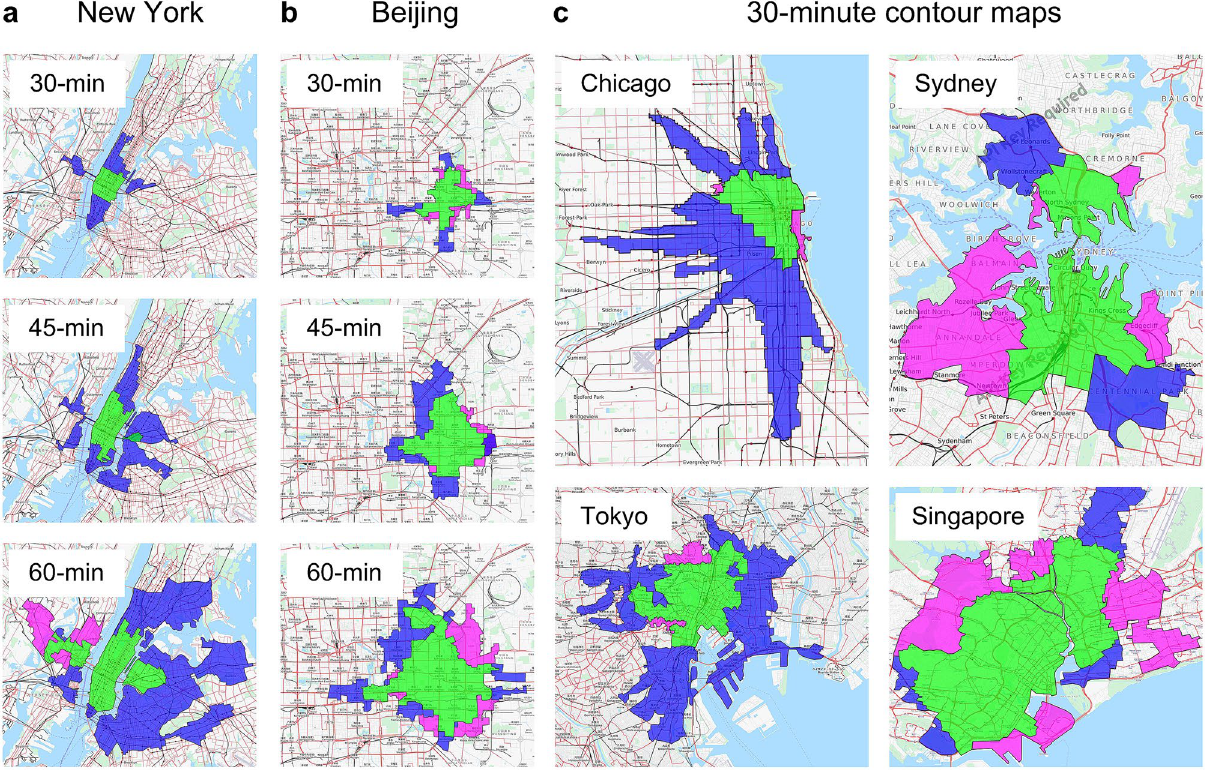
Figure 2. Contour maps of fastest or equal driving time between PT and PCs (Supplementary Tables 2, 3 and 4) . PCs are faster than PT (represented in pink); PT is faster than PCs (represented in blue); and the case of equal travel time (represented in green). ( a ) Contour maps for the Lower Manhattan zone of New York showing the fastest modes for reaching destinations within 30, 45, and 60 min between 5:00 and 6:00 p.m. from midtown. ( b ) Contour maps, similar to ( a ), for Guomao zone of Beijing between 5:00 and 6:00 PM from Yintai Center. ( c ) Two strong and two poor PT-related cities in comparison to PC travel times using 30-min contour maps between 5:00 and 6:00 p.m. The selected starting points are from Chicago’s CBD area, Tokyo’s Bunkyo, Sydney’s CBD area, and Singapore’s city